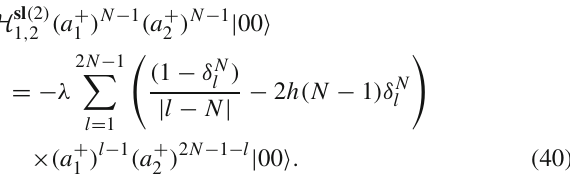
comparison for κ = 0 and κ = 1. N goes up to